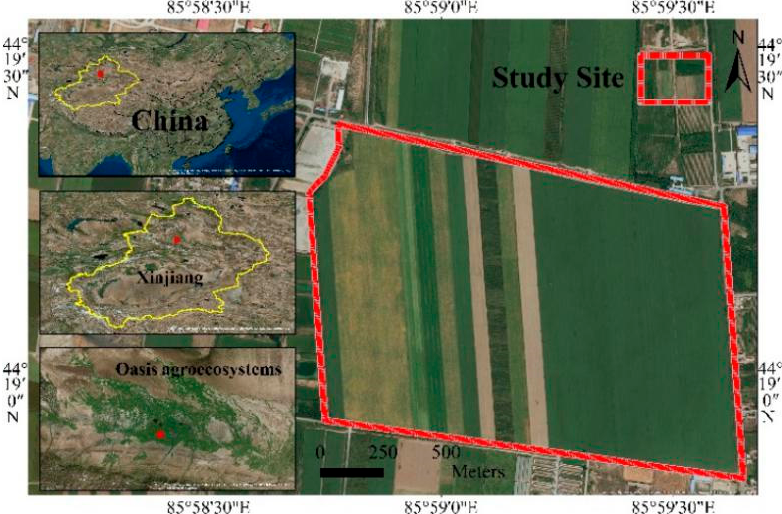
Figure 1. The experimental location.